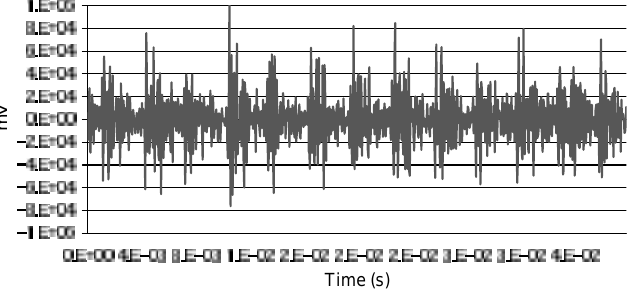
Fig. 6. A measured sound pressure of noise emitted from the simulated chain drive.